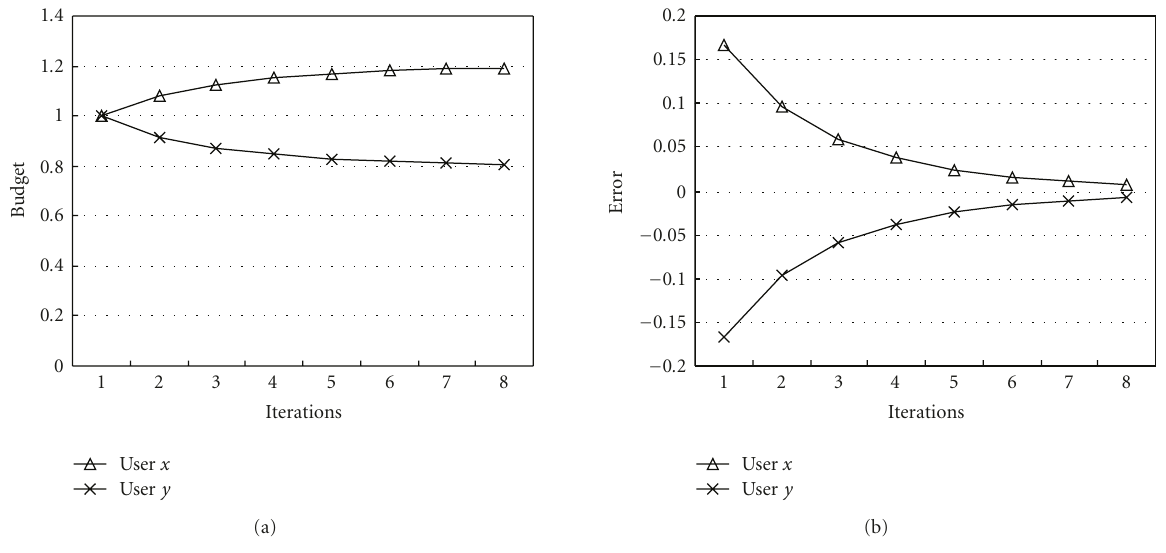
Figure 2: Convergence of iterative algorithm for satisfying power demands. Table 1: Number of iterations required to achieve the budget allocation where the competitive equilibrium satisfies power demands d i = (cid:6) (cid:6) 0 . 5( ) and d i = by the iterative algorithm, error tolerance = 0.01, average of 10 simulation runs. j s j /m j s j /m